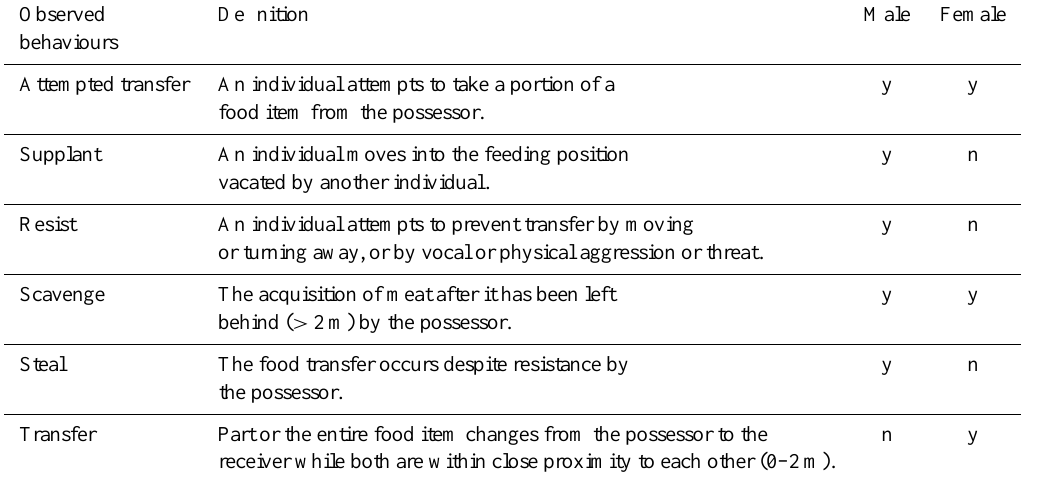
Table 1. Terminology of meat sharing and whether or not they were observed to occur between male–male and male–female dyads.